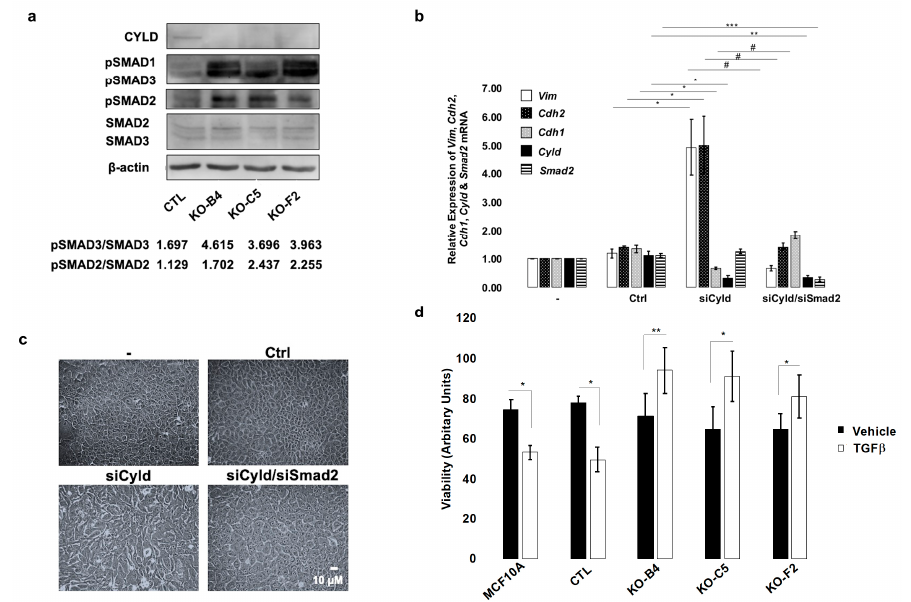
Figure 4. CYLD-regulated mammary EMT depends on the activation of the TGF β signaling pathway. ( a ) Immunoblot analysis of CYLD pSMAD1, pSMAD2, pSMAD3, SMAD2, SMAD3, and β -actin expression in whole cell extracts from control (CTL) and CYLD-deficient MCF10A cells (KO-B4, KO-C5, and KO-F2). The indicated ratios of band intensities are shown below the corresponding lane. ( b ) Simultaneous CYLD and SMAD2 downregulation inhibits the EMT process that is induced by CYLD downregulation. MCF10A cells were transfected with CYLD -targeting (siCyld), SMAD2 -targeting (siSmad2), or luciferase-targeting (Ctrl) siRNAs as indicated. After 48 h, total RNA was extracted and used to determine the relative levels of the indicated vimentin (Vim), E-cadherin (Cdh1), N-cadherin (Cdh2), CYLD (Cyld), and SMAD2 (Smad2) mRNAs by qPCR. The histogram indicates the average endogenous control, from at least three independent experiments. The statistical analysis of